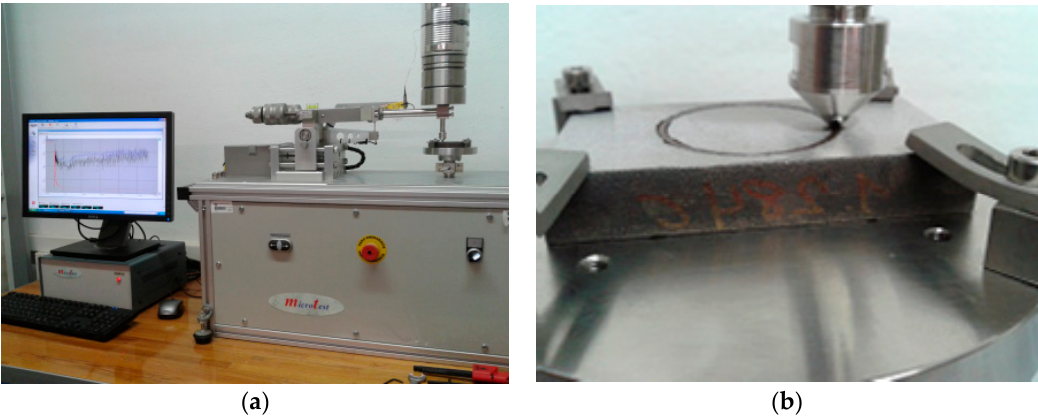
Figure 2. Pin-on-disk laboratory test equipment used for the experiments ( a ) and detail of the wear track created by the turning the tungsten carbide (WC) counter ball over the sample surface ( b ).